Question: Express in one sentence what the figure is showing.
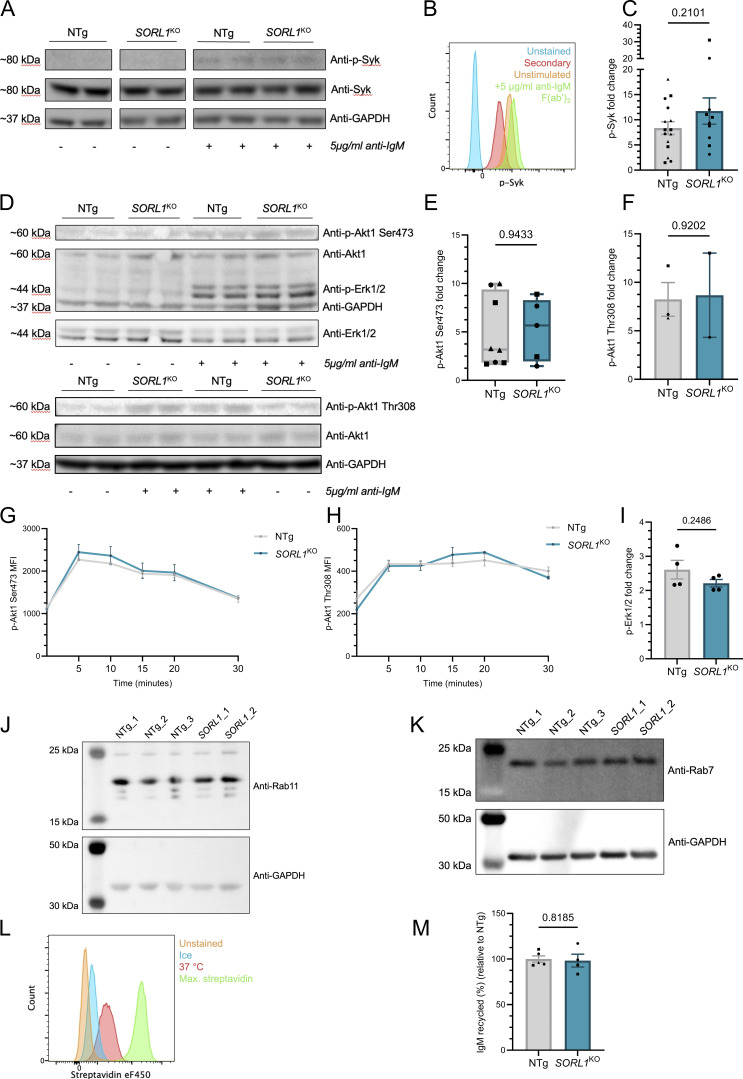
Answer: SorLA localizes to endolysosomal compartments in Ramos B cells. (A) Confocal micrograph showing surface and intracellular SorLA-EGFP localization in Ramos cells. 100× magnification; inset (blue box) shows an enlarged view of an individual cell. Scale bars = 10 µm. (B) Representative flow cytometry histograms for control secondary antibody only stain (orange), unpermeabilized cell surface SorLA stain (red), and 0.01% Triton X-100 permeabilized total SorLA stain (blue). (C) Surface SorLA expression as % of total by flow cytometry. Surface SorLA expression = (surface SorLA MFI/total SorLA MFI) × 100. n = 9 independent Ramos-Cas9 transductions with three NTg sgRNAs (indicated by symbols) from three independent experiments. Data show mean ± SEM. (D) Quantification of SorLA-EGFP colocalization with organelle markers. Voxel-based Manders’ coefficient. Rab5: n = 31 cells, Rab11: n = 90 cells, Rab7: n = 60 cells, and LAMP1: n = 41 cells from 10 images from two independent experiments. (E) Quantification of endogenous SorLA colocalization with organelle markers at 5, 15, 30, and 60 min after addition to PMS presenting anti-IgM surrogate antigen. Manders’ coefficient. Rab5: n = 13–31 cells, Rab11: n = 7–29 cells, Rab7: n = 7–31 cells, and LAMP1: n = 27–58 cells from four independent experiments. These intracellular compartments are not mutually exclusive; thus, SorLA puncta may be positive for several markers and be counted under >1 organelle. Data are shown as box and whisker plots, where the line indicates the median, the box represents the interquartile range, and whiskers denote the minimum and maximum values. (F) Representative fluorescence micrographs of Ramos-Cas9 cells on PMS presenting anti-IgM surrogate antigen at 15 min. Images show SorLA (magenta), vesicle markers (cyan), and an overlay from a single z-stack slice (ImageJ). “3D” column shows a 3D projection of the overlay z-stack (Imaris). Colocalization appears white.